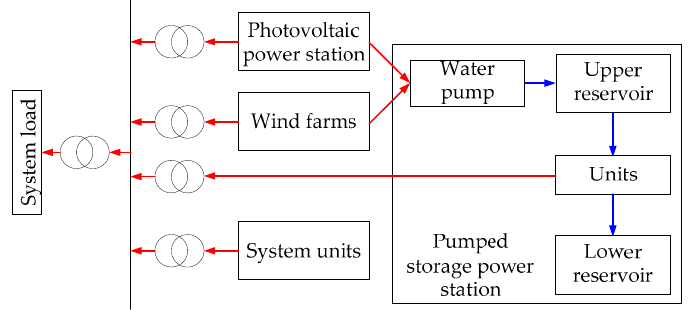
Figure 1. The structure of wind power-photovoltaic-pumped storage system.